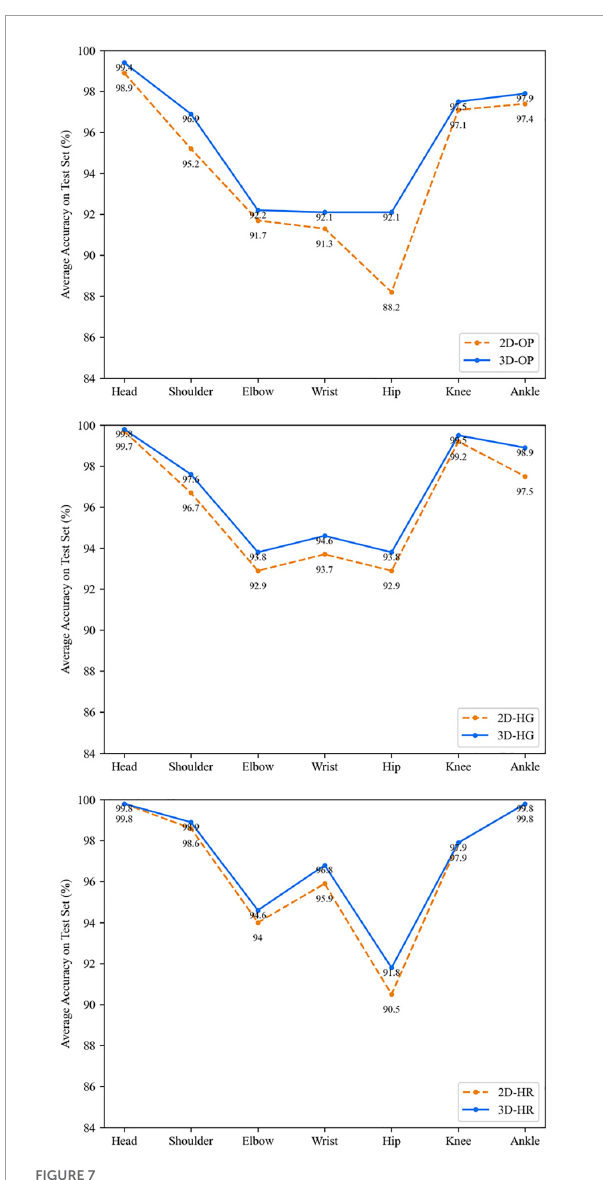
FIGURE7 The detailed performance of different networks comparing 2D and mean of